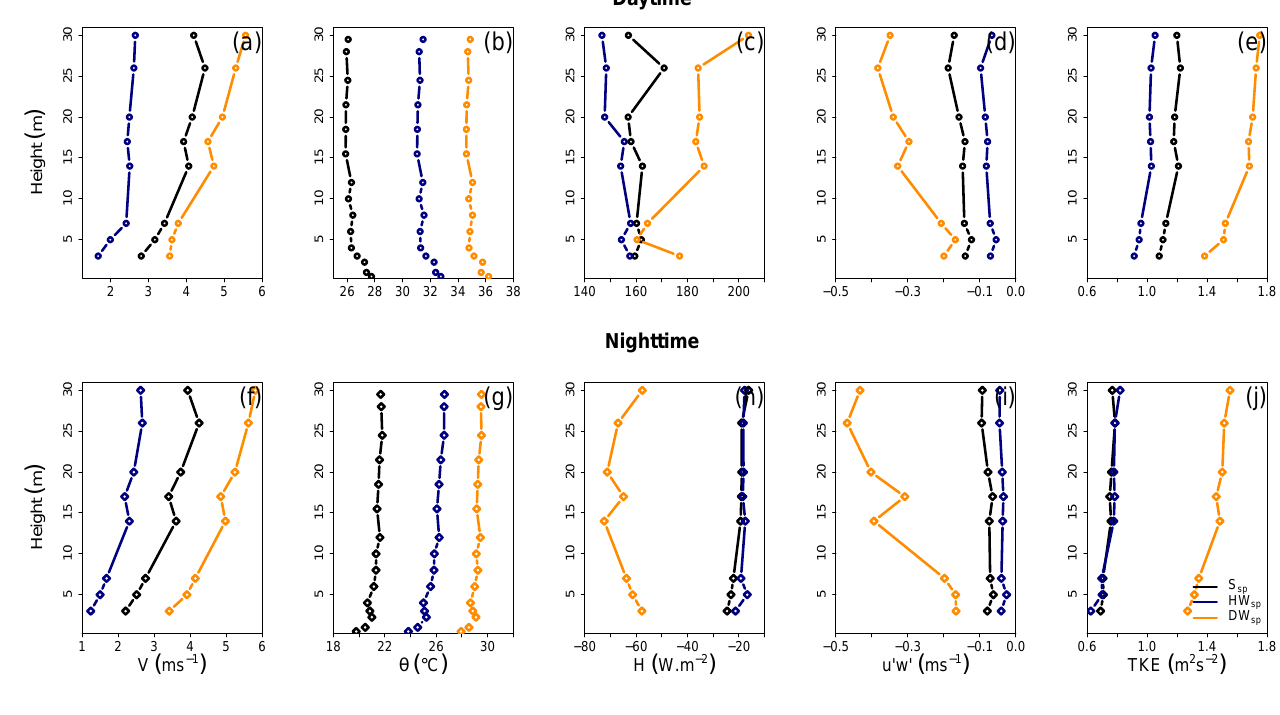
Figure 9. Vertical profiles of ( a , f ) wind speed ( V ), ( b , g ) air potential temperature ( θ ), ( c , h ) sensible heat flux ( H ), ( d , i ) momentum flux ( u (cid:48) w (cid:48) ), and ( e , j ) turbulent kinetic energy ( TKE ), for S sp (black), HW sp (blue), and DW sp (orange); ( a – e ) refers to daytime, while ( f – j ) is for nighttime. The plots refer to the 30 m micrometeorological